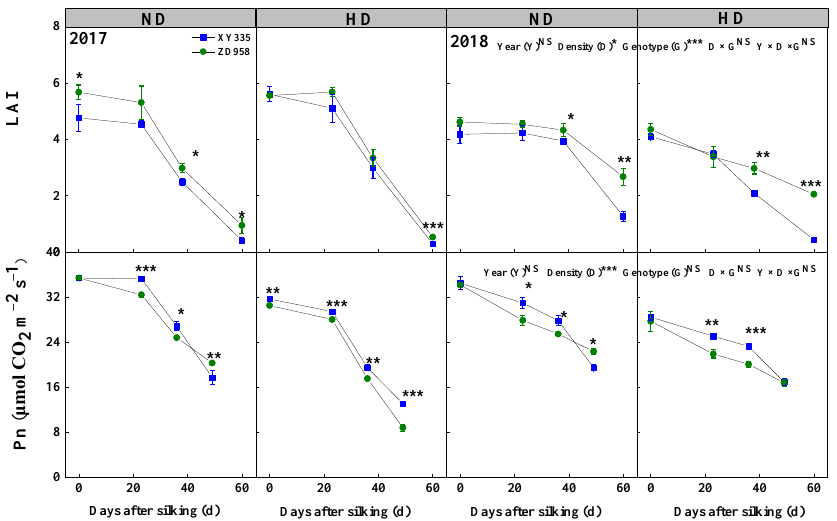
Figure 3. Dynamics of LAI and Pn of ear leaves from two maize hybrids grown under ND and HD conditions in 2018. LAI, Leaf area index; Pn, Net photosynthetic rate. ND and HD indicate 60,000 and 90,000 plants ha − 1 density, *, ** and *** indicate significant difference at p < 0.05, p < 0.01, p < 0.001, and NS, no significance, respectively. Bars denote standard error ( n = 3).